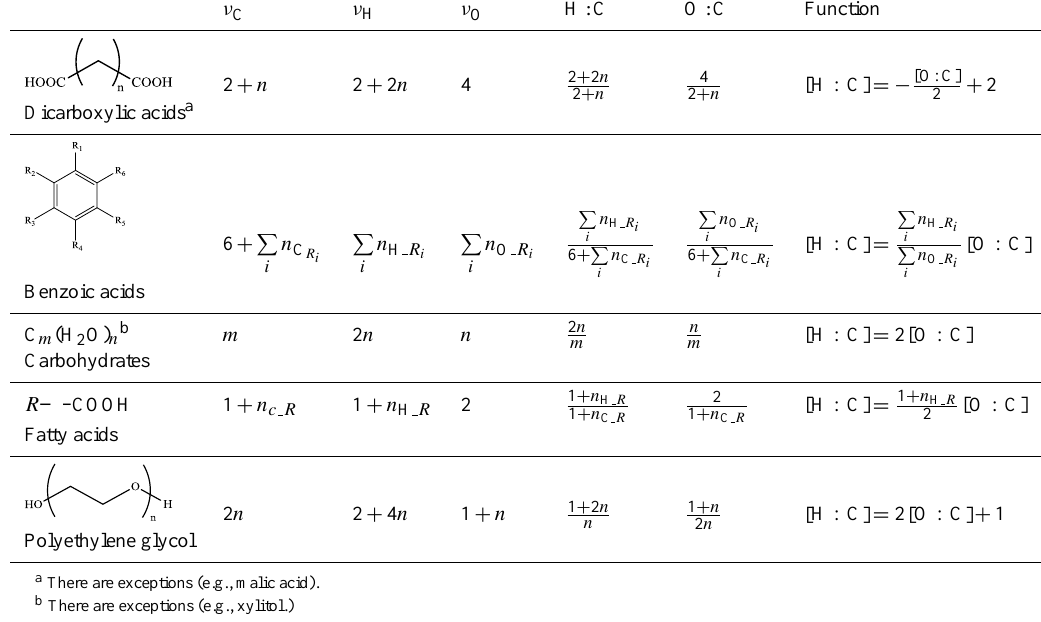
Table A2. The positions and functions of each type of compounds on the van Krevelen diagram. ν C , number of carbon atoms; ν H , number of hydrogen atoms; ν O the number of oxygen atoms. The term n x R denotes the number of atoms x in R i . See Appendix A2 for detail.